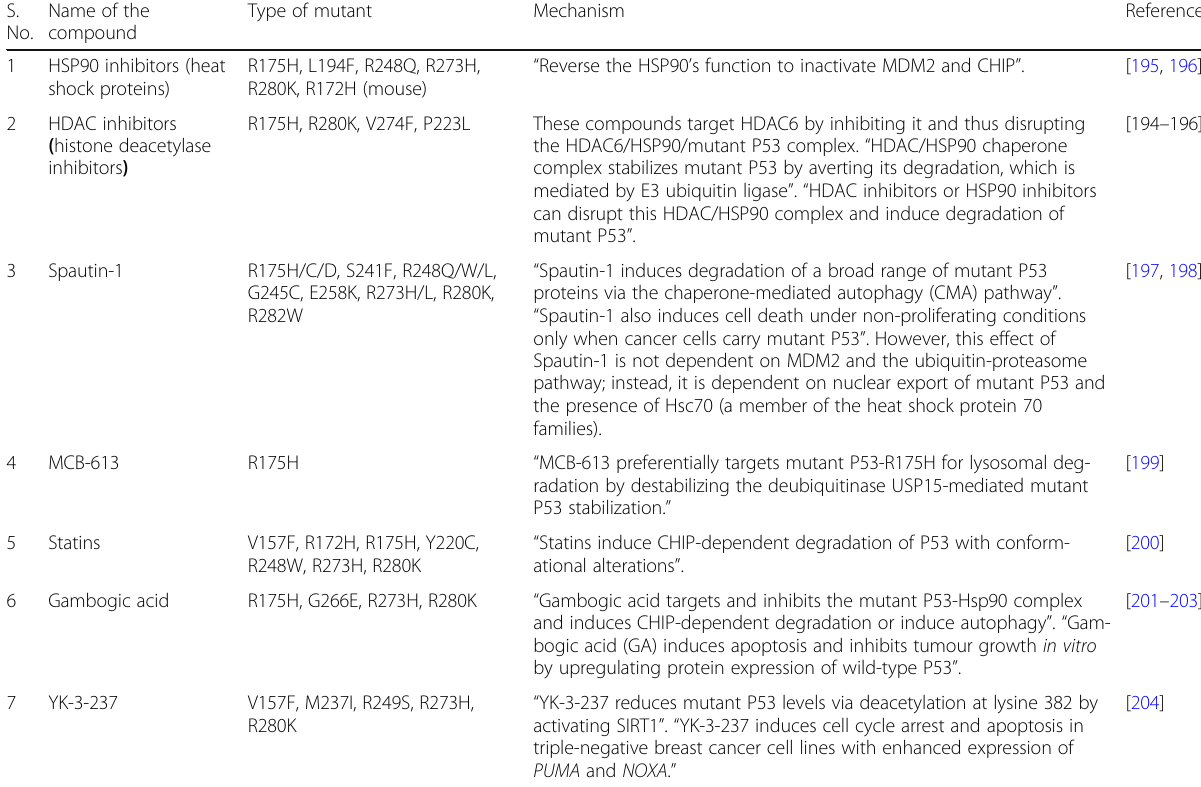
Table 2 Compounds that target mutant P53 and induce degradation of mutant